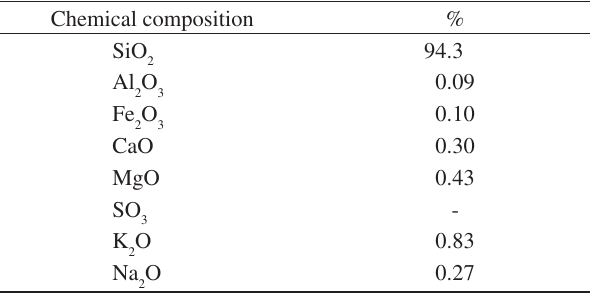
Table 3. The chemical compositions of silica fume.